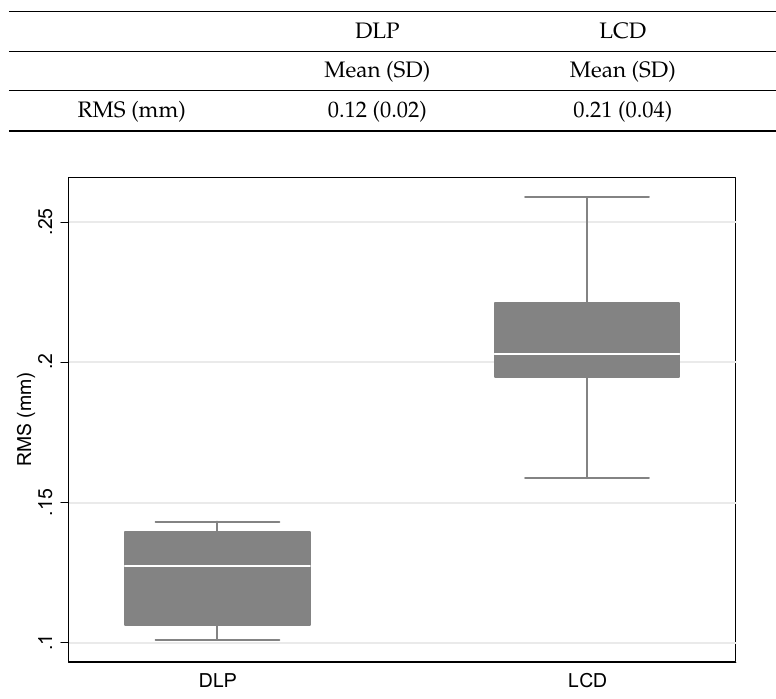
Figure 4. Boxplot of the distribution of RMS measurements by printer type.